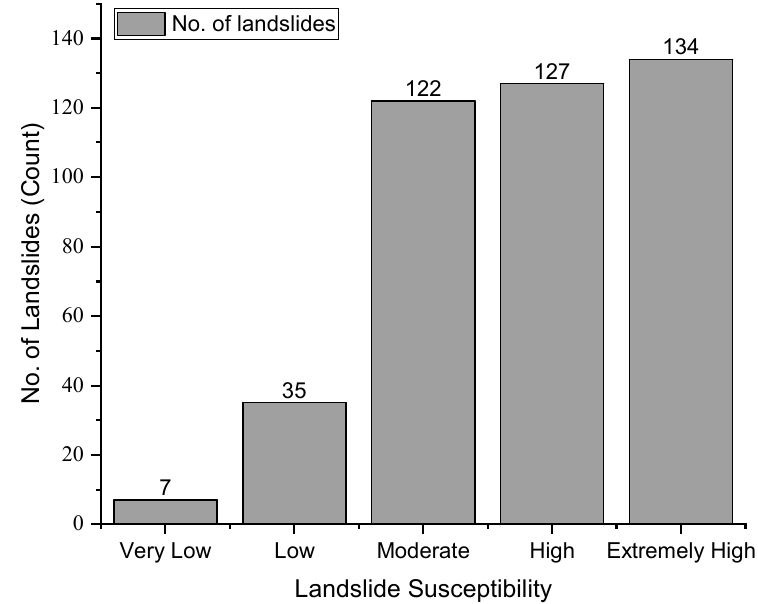
Figure 8. Distribution of known landslides in each landslide susceptibility level.